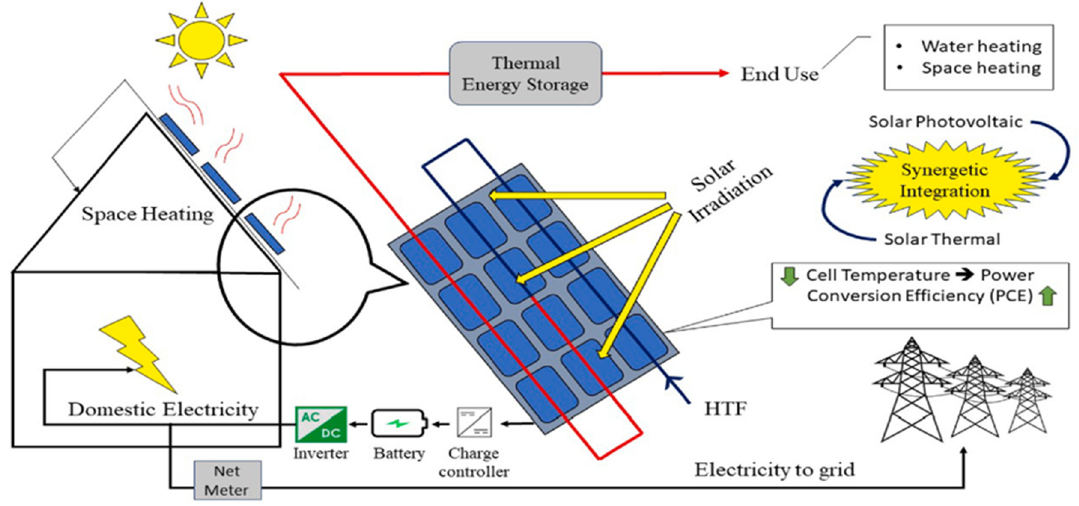
Figure 7. A schematic of PV/T working system and its applications [135], with permission No.